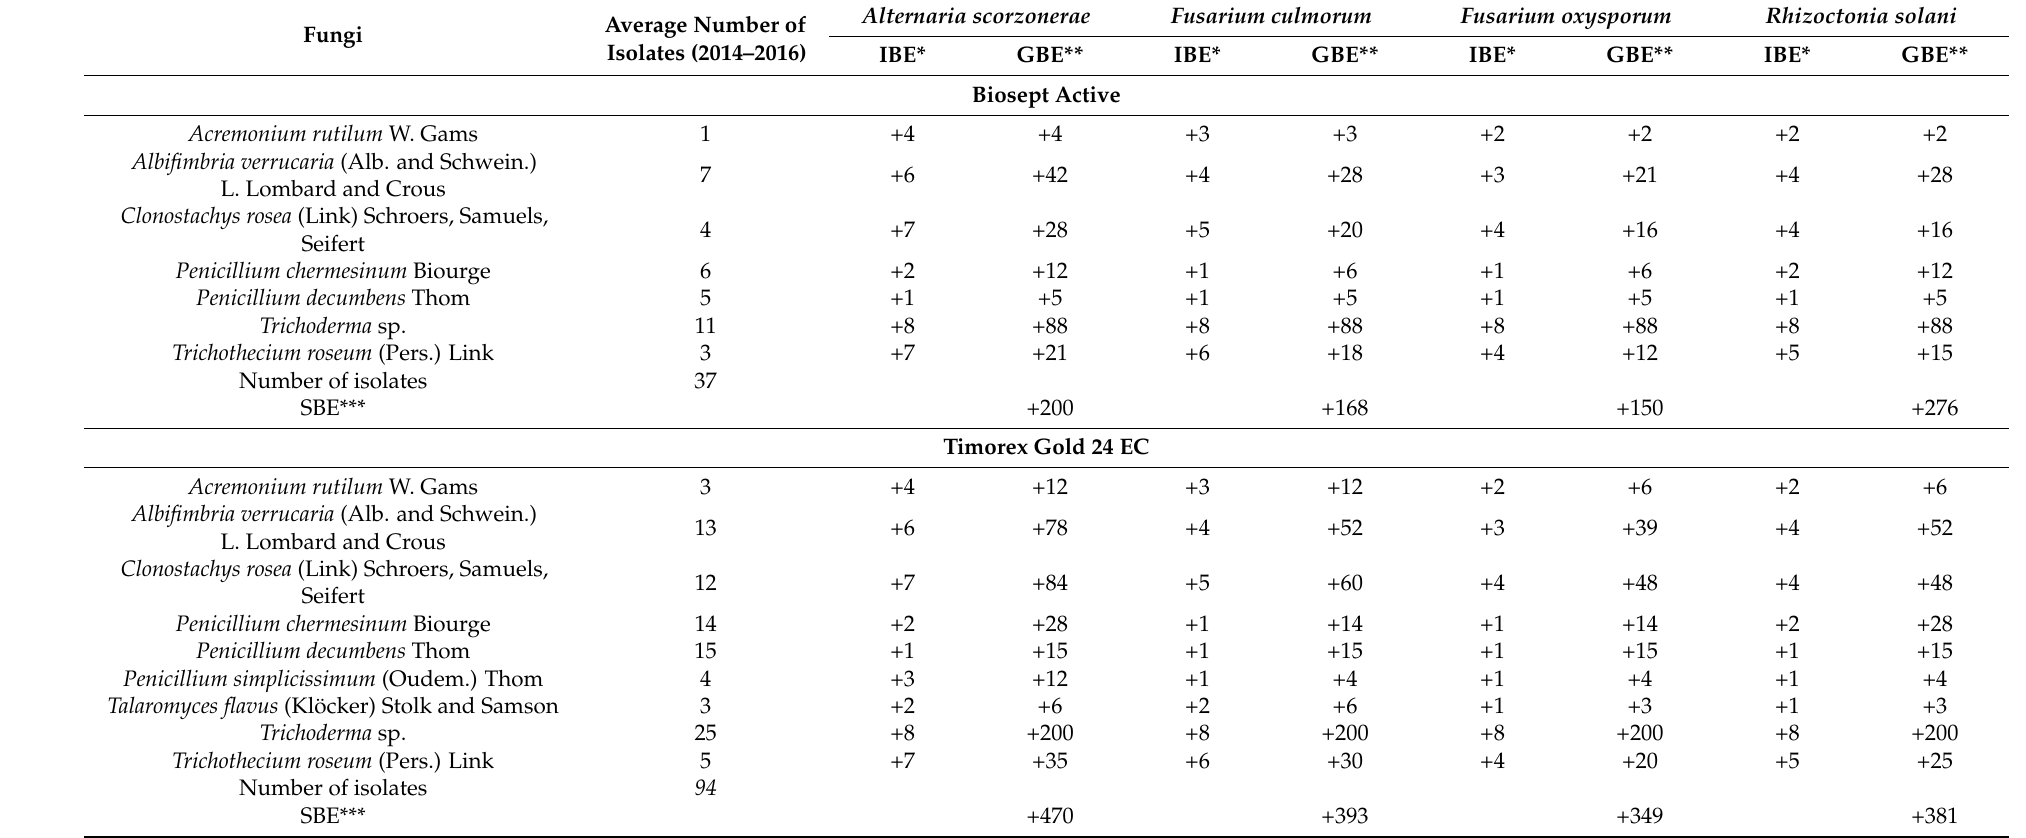
Table 6. Antagonistic activity of selected fungi isolated from the scorzonera rhizosphere towards pathogenic